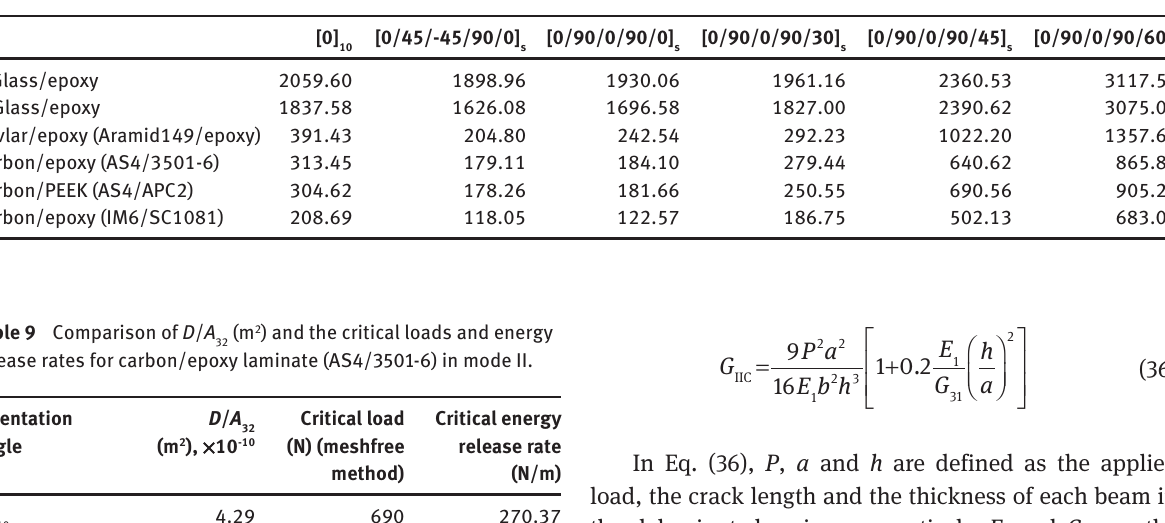
Table 8 Comparison of the critical energy release rate G (N/m) obtained from meshfree methods (nodes: 11 ×